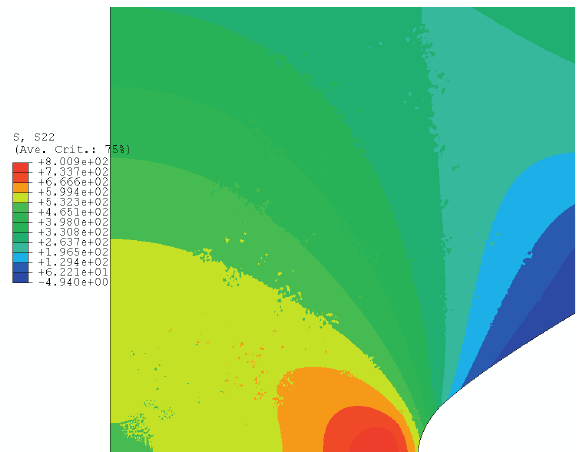
Figure 12(a). Axial stress. Stress contours in the notched region for 22N steel at 823 K. Nominal stress D 431 MPa.